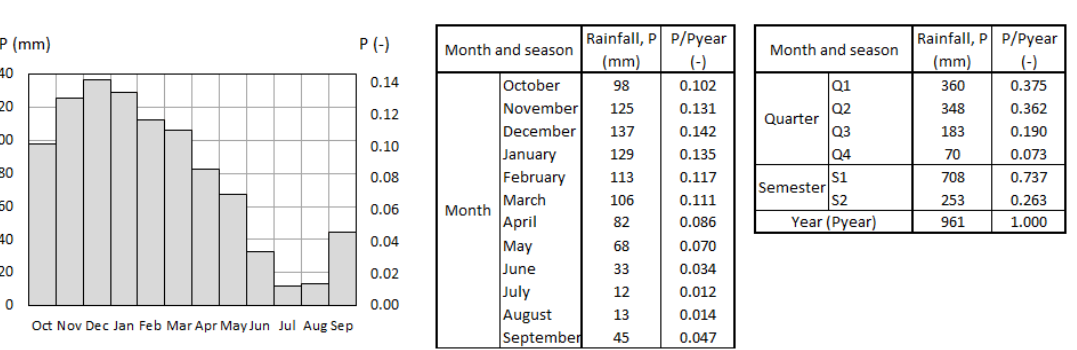
Figure 4. Average monthly (figure and table) and seasonal (table) rainfalls at the 532 rain gauge locations of Figure 1 in the period from 1913/1914 to 2018/2019 expressed in mm and by their relative contribution to the mean annual rainfall. Q1 to Q4 stand for the quarters and S1 and S2 for the semesters of the hydrological